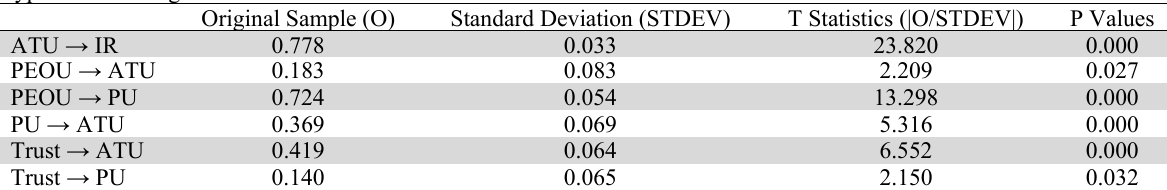
Hypothesis Testing Original Sample (O) Standard Deviation (STDEV) T Statistics (|O/STDEV|) P Values ATU → IR 0.778 PU → ATU Trust → ATU Trust → PU